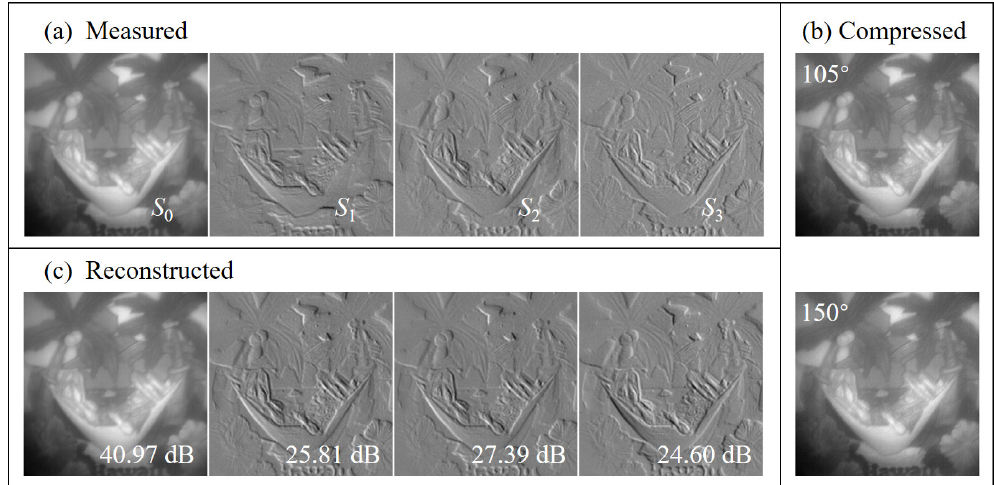
Figure 4. The ( a ) measured, ( b ) compressed and ( c ) reconstructed images in the spectral band of 600